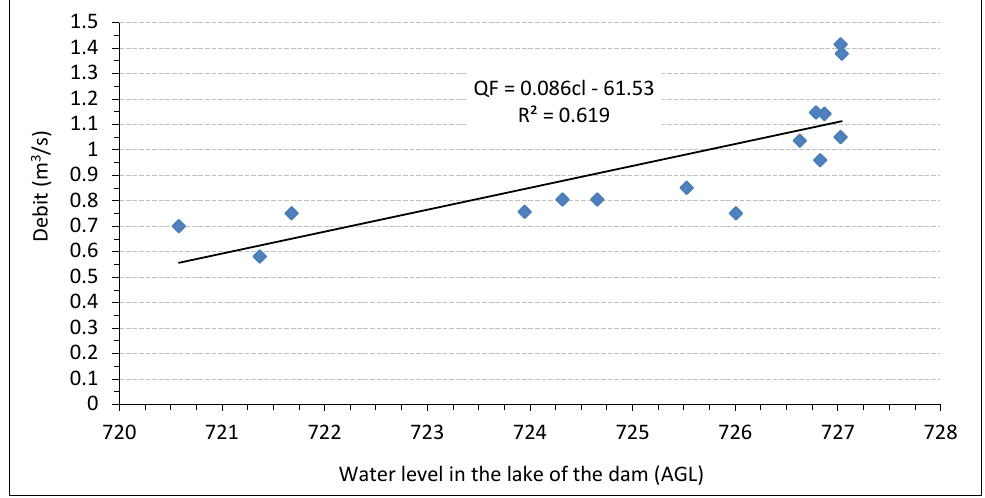
Figure 37. Variation of the leaked flow as a function of water level for heights between720.5 m and the normal level of the reservoir